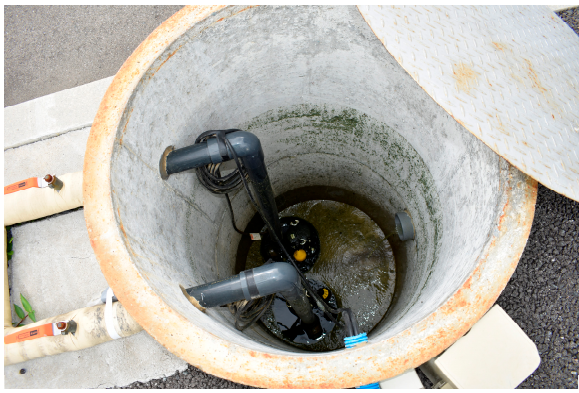
Figure 4. Pumps for harvest in cultivation sub-unit at Minamisoma (0.55 kW × 2 units).